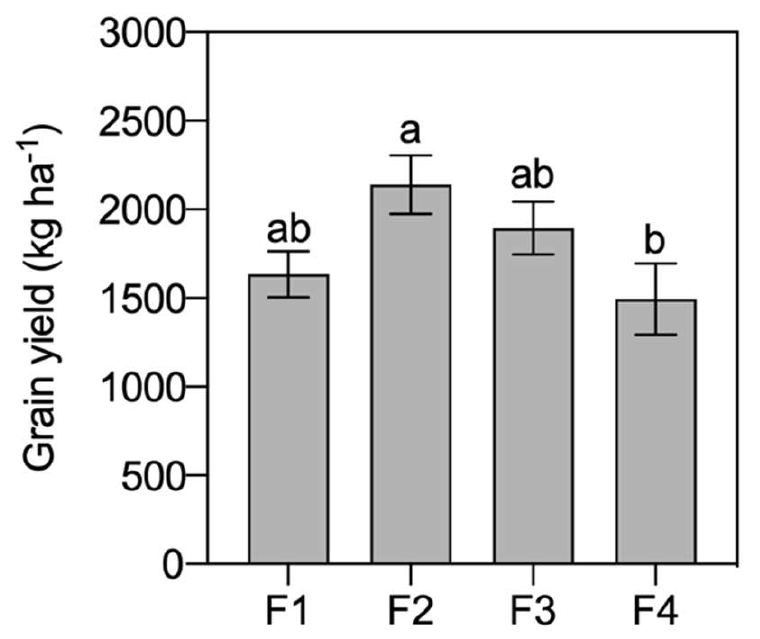
Figure 1. Grain yields in an extensive experimental site in Chanco, Maule region, central Chile. Small letters indicate differences among sites according to Tukey test ( p < 0.05). F = farmer.